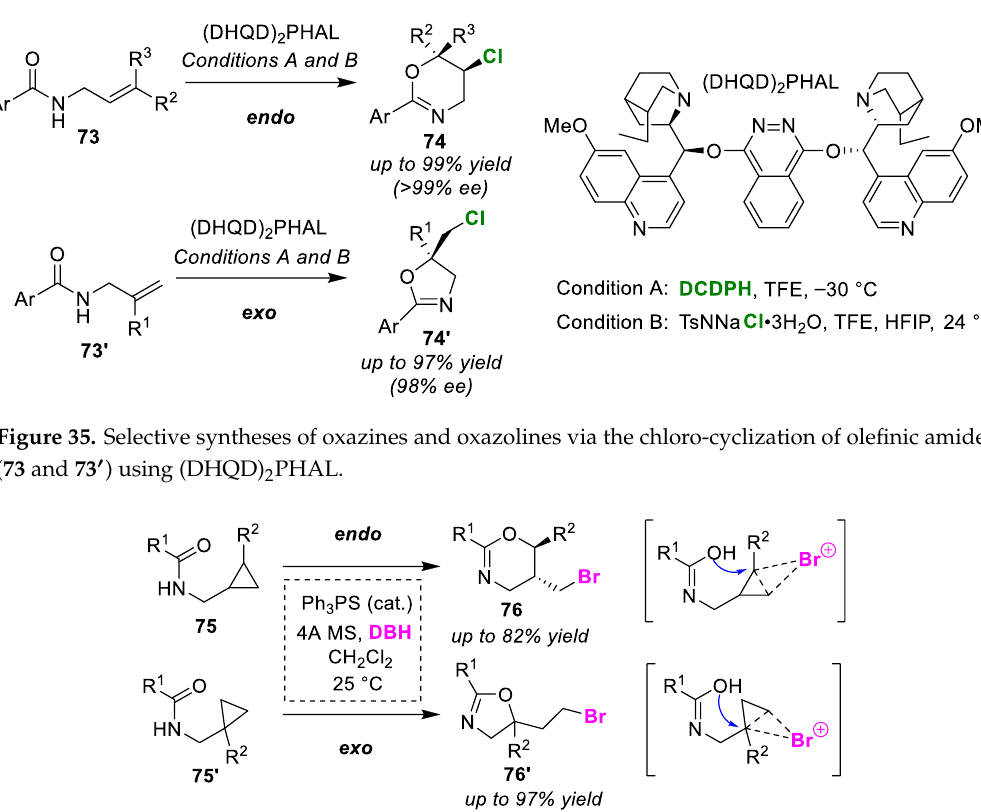
Figure 36. Heterocycle formations of oxazines 76 and oxazolines 7 6′ from cyclopropyl amides ( 75 and (cid:48) ) via bromocyclization reactions using a Lewis basic sulfide 7 5′ ) via bromocyclization reactions using a Lewis basic sulfide catalyst. 75